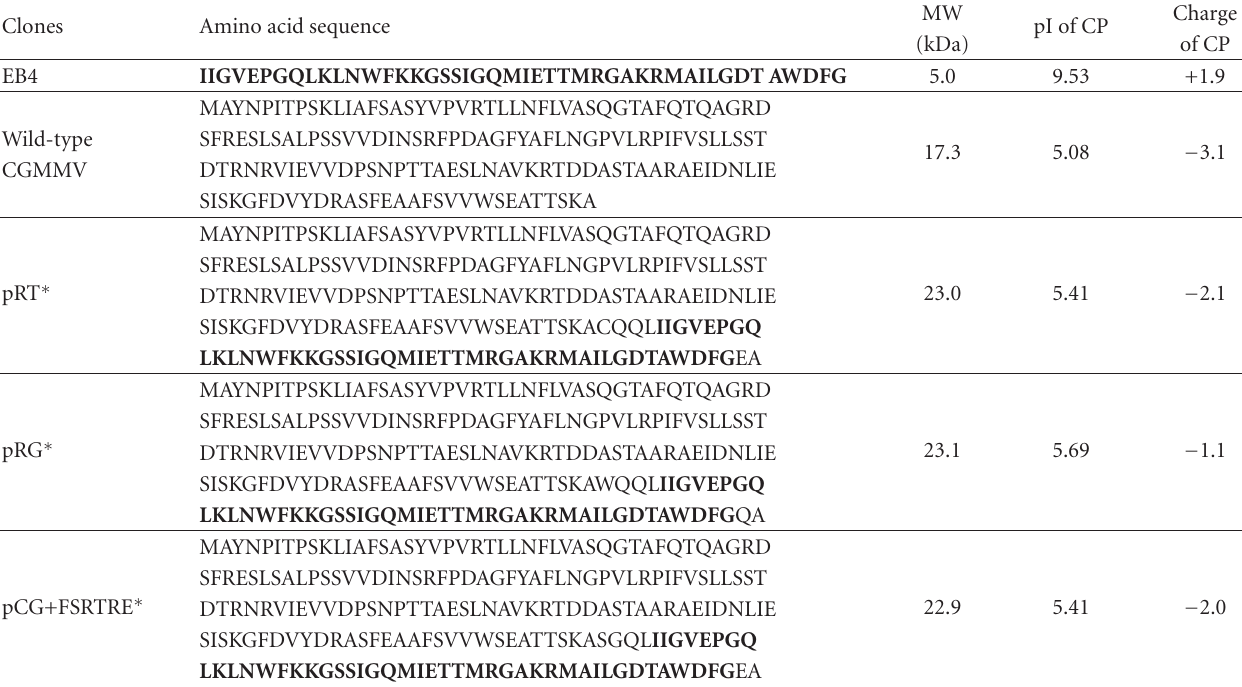
Table 2: Amino acid sequence, isoelectric point (pI) and charge of wild type, constructed recombinant CGMMV coat protein (CP), and the EB4